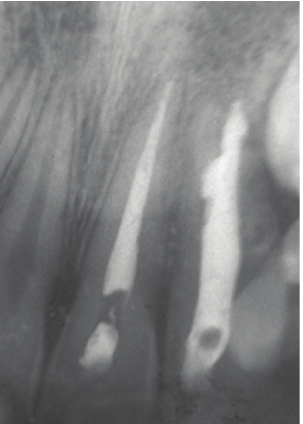
Figure 3: Periapical radiograph showing the root canal treatment of tooth 21 after 1 month (third session; April 1998).